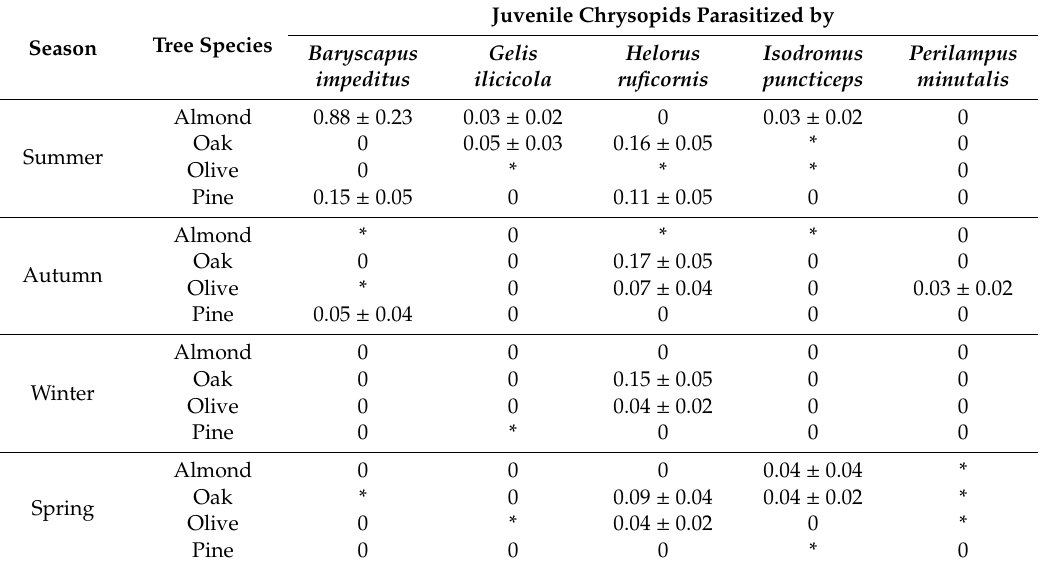
Table 5. Abundance of juvenile chrysopids parasitized (mean ± SE) by the parasitoid species complex in almond, oak, olive and pine trees by